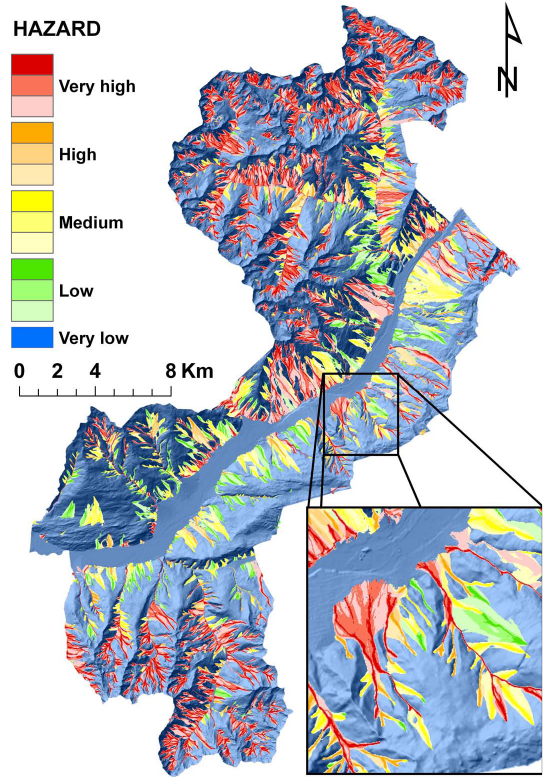
Fig. 9. Debris flow hazard map B showing qualitative information on the runout spreading probabilities. The map is classified in five main hazard classes, each one subdivided in three sub-classes showing the spreading direction probabilities (debris flow volume